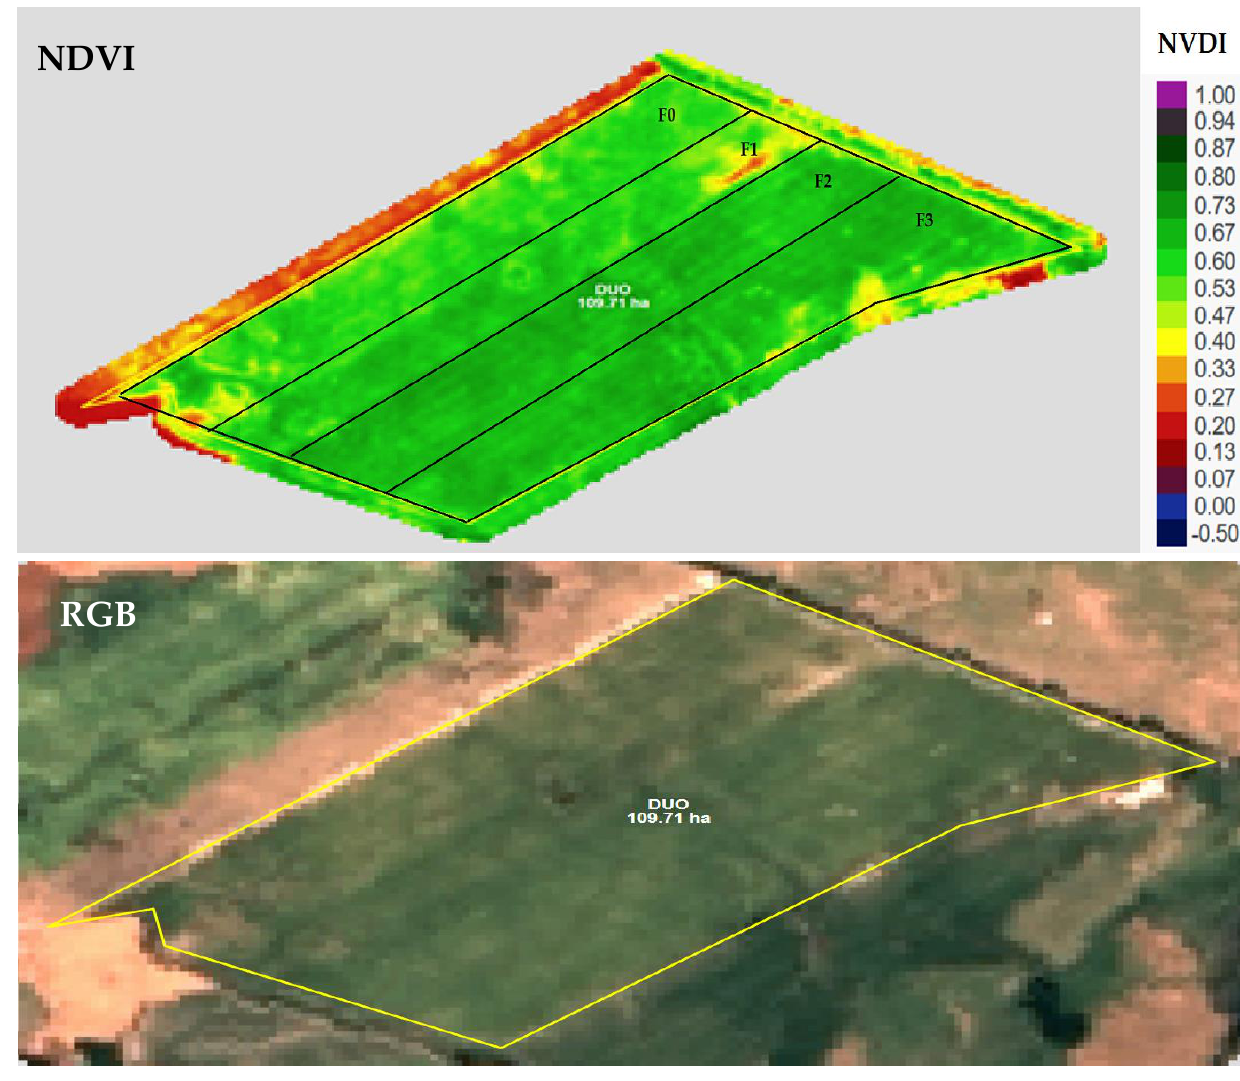
Figure 5. Map with vegetation index (NDVI) and visual (RGB) preview from July 13. Note: F0 — control; F1 — foliar fertilization; F2 — localized fertilization: microgranules for precision application into the soil; F3 — localized fertilization: microgranules for precision application into the soil with foliar fertilization.